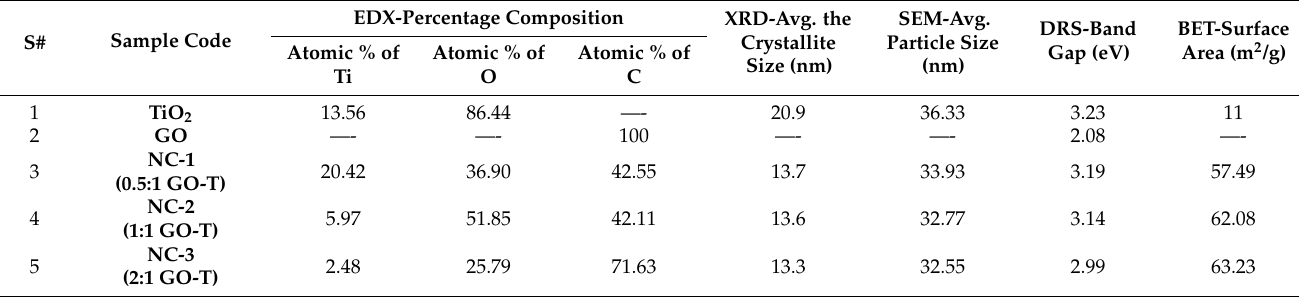
Table 2. Table represents the EDX-% composition, avg. The crystallite size (nm), avg. particle size (nm), Bandgap (eV), and surface area (m 2 /g) of all the prepared